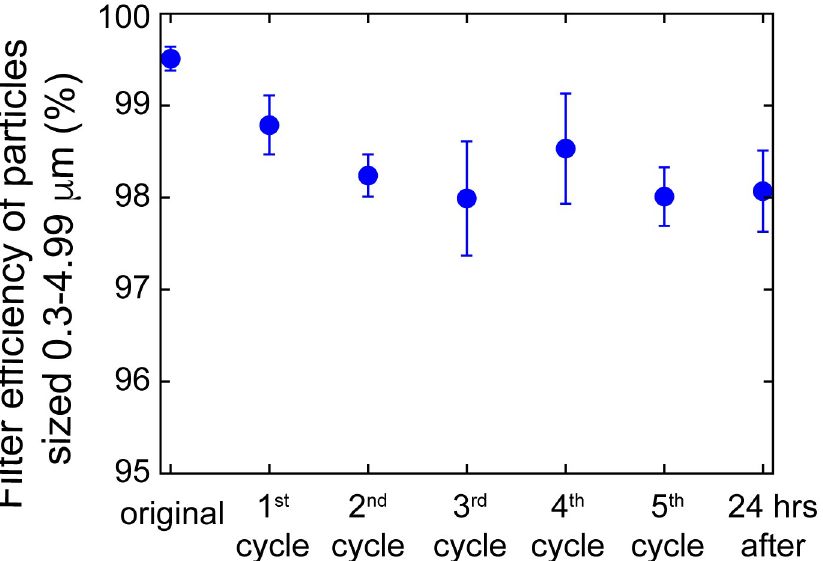
Fig 4. Filtering efficiency of particles sized 0.3–4.99 μ m, at an intake rate of 2.83 l/min, of Kimberly Clark N95 respirators undergoing cycles of heat treatments using the method detailed in this protocol with 2L of boiled